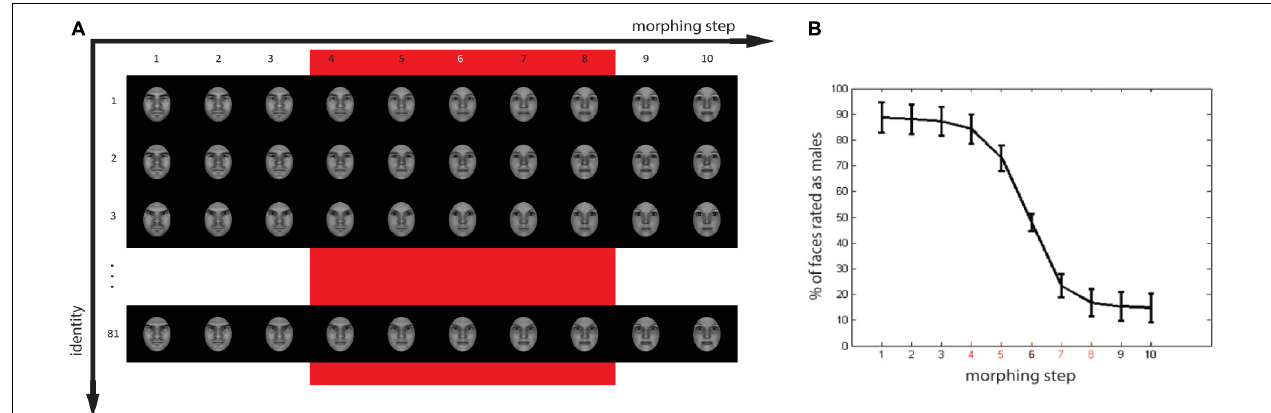
FIGURE 2 | (A) Stimuli set with 81 artificially generated identities, each of which was morphed in ten steps across the male to female spectrum. The red square indicates the stimuli selected for the experiment. (B) Proportion of faces evaluated as males as a function of morphing step. Faces of morphing steps 4 (very male), 5 (less male), 6 (ambiguous), 7 (less female), and 8 (very female) were selected for the main experiment. Faces of step 6 were not included in the analysis [white marker in panel (A) and black in panel (B) ].